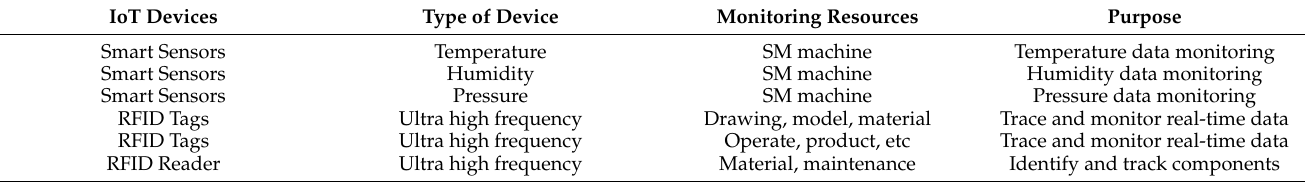
Table 4. IoT device configuration information for data usage in smart manufacturing. IoT